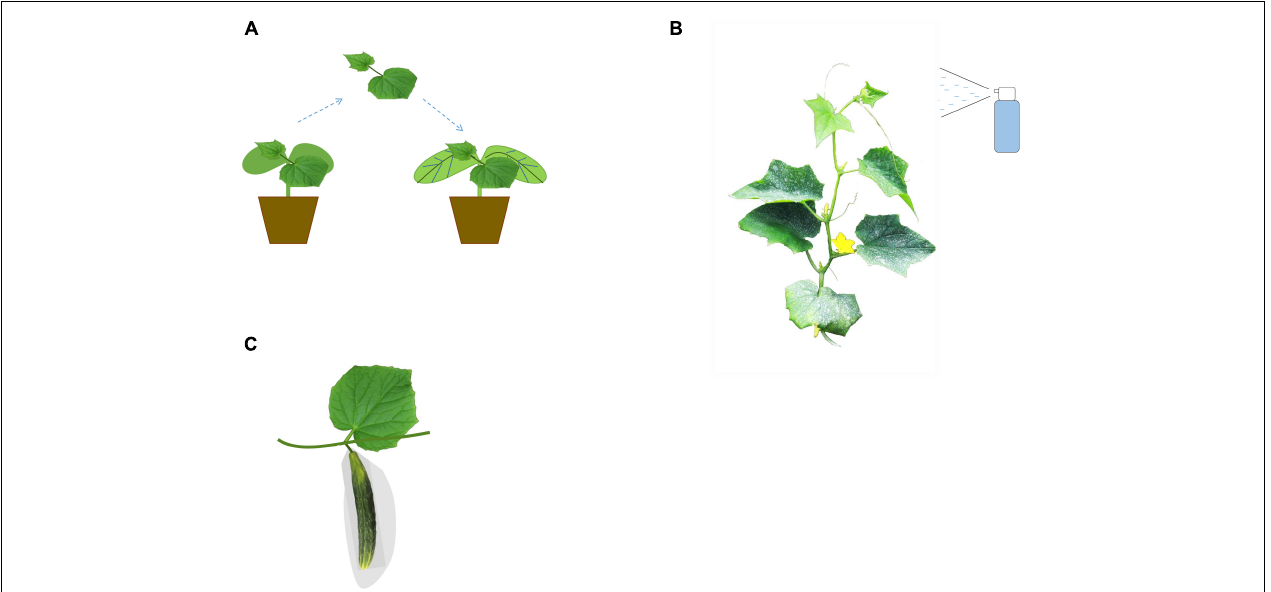
FIGURE 2 | Illustration of the cultivation techniques in cucumber fruit quality breeding. Grafting technique (A) , application of exogenous fertilizers and growth regulators (B) , and bagging technology (C) are widely used in cucumber fruit quality breeding. quality after bagging, for the elevated relative proportion of C6 aldehyde, ( E,Z )-2,6-nonadienal/( E )-2-nonenal ratio, and linoleic/ α -linolenic acid